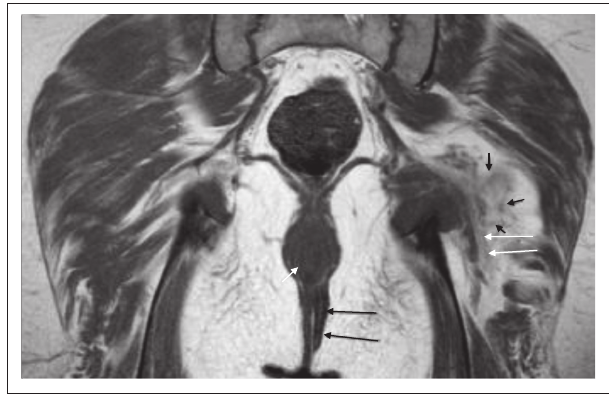
FIGURE 6: Coronal T1W image. A perianal fistula (long black arrows) extending vertically from the anus (short white arrow) to the natal cleft. The vertical course of the sciatic nerve (long white arrows) is closely related to inflammatory changes in the adjacent fat (short black arrows) which may account for the presentation mimicking